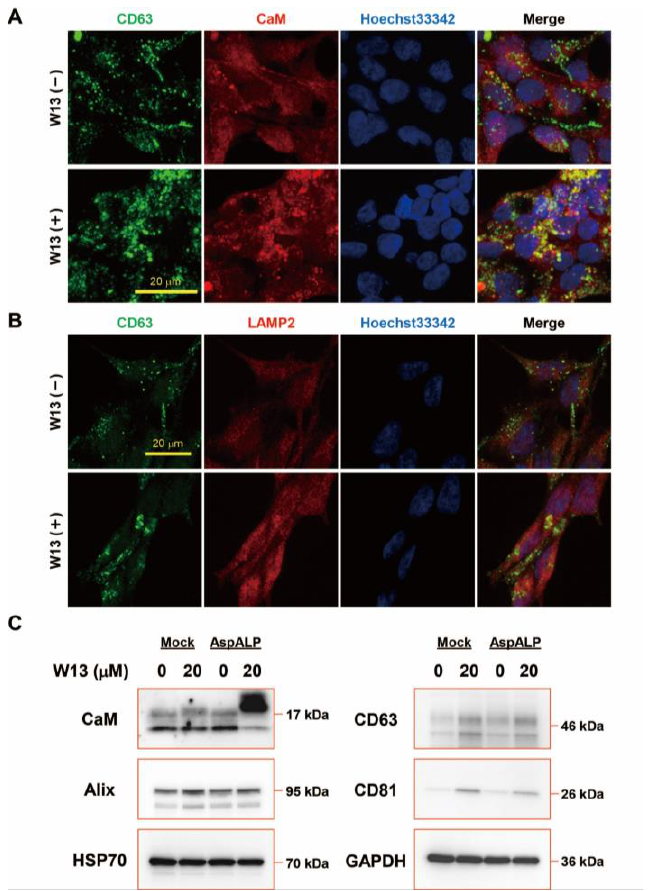
Figure 3. Exosomal cargo proteins in T-REx cells in the absence or presence of W13. ( A ) Distribution of CD63 and CaM in T-REx AspALP cells in the absence ( − ) or presence (+) of W13 for 72 h. ( B ) Distribution of CD63 and LAMP2 in T-REx AspALP cells in the absence ( − ) or presence (+) of W13 for 72 h. ( C ) Western blot analysis of exosomal cargo proteins from T-REx cells in the absence or presence of W13 for 72 h. Representative images from three independent experiments.